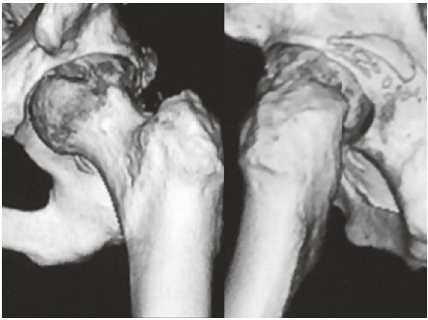
Figure2:Computedtomographyofthelefthipjointafterreduction.